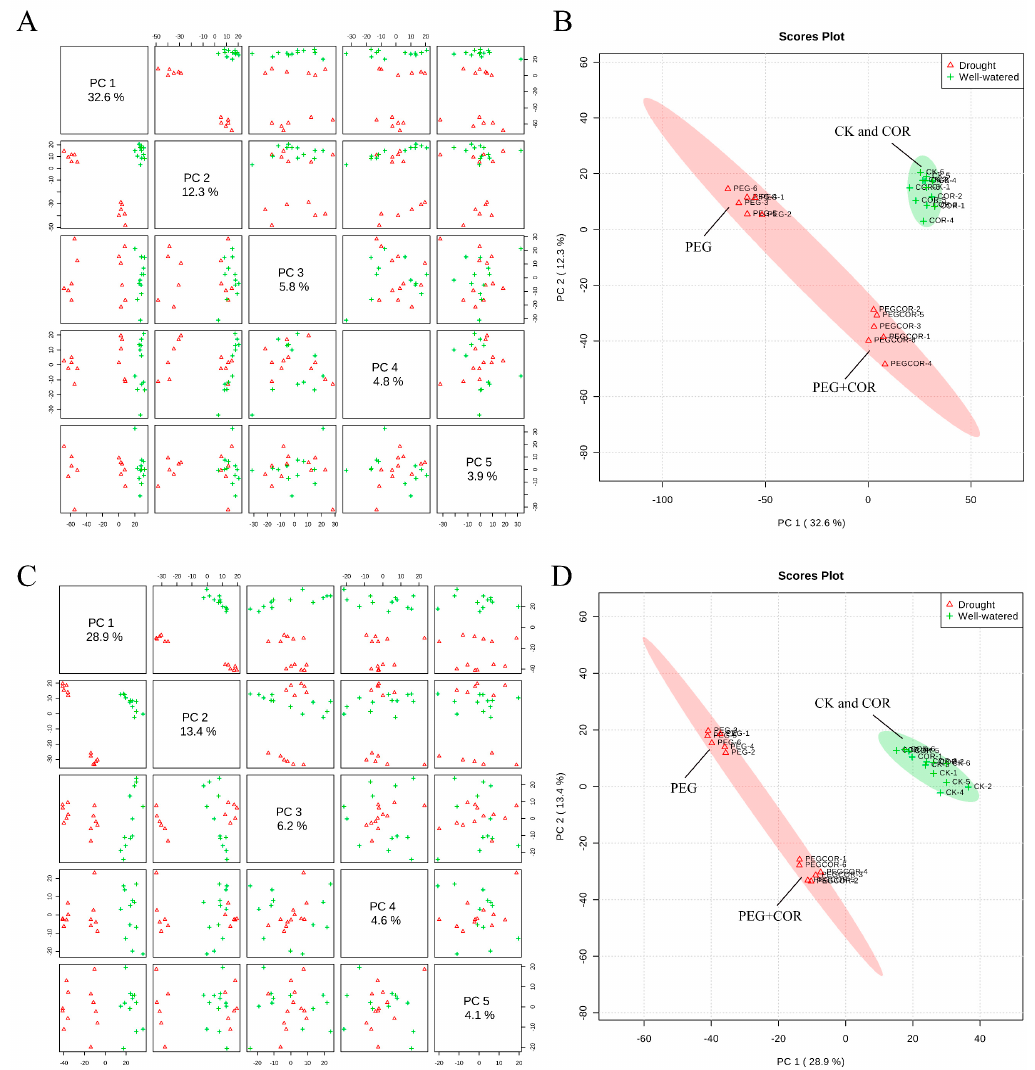
Figure 4. Principal component analysis and 2D score plot of metabolites in tobacco leaves between COR and control treatments in the positive ion mode ( A , B ) and negative ion mode ( C , D ). CK, normal conditions without COR and PEG treatment; COR, treatment with 1 nM COR; PEG, osmotic stress induced by PEG without COR treatment; PEG + COR, pretreatment with 1 nM COR under PEG stress.